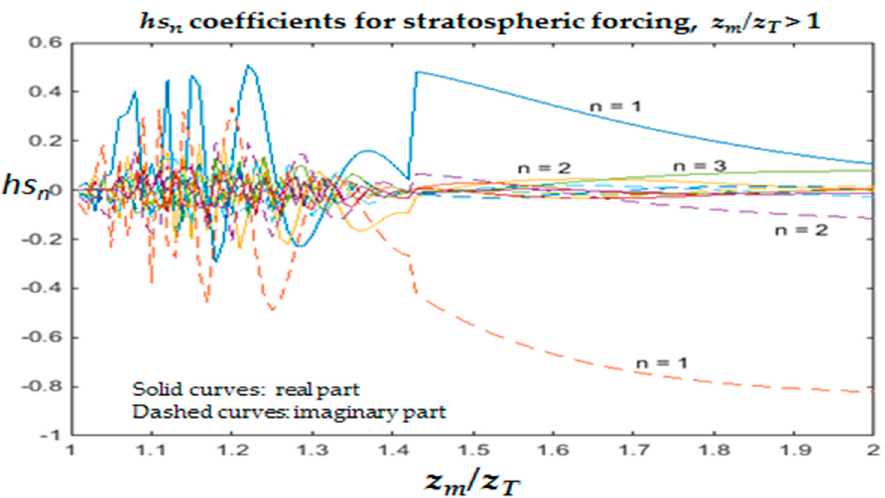
Figure A3. Complex Fourier coefficients B ( n ) from Equation (A3) for forcing from within the stratosphere of wave motion that may impact on the troposphere. Only modes n = 1–3 are shown, the solid curves denoting real parts and the dashed curves imaginary parts. H s = 9 km. Note the relatively small and almost indeterminate values in the range 1 < z M / z T < 1.4. For forcing from within the stratosphere of waves that enter the troposphere and impact on surface pressure, the corresponding Fourier coefficients are the B ( n ) defined by Equation (A3). These have complex values that are shown in Figure A3.